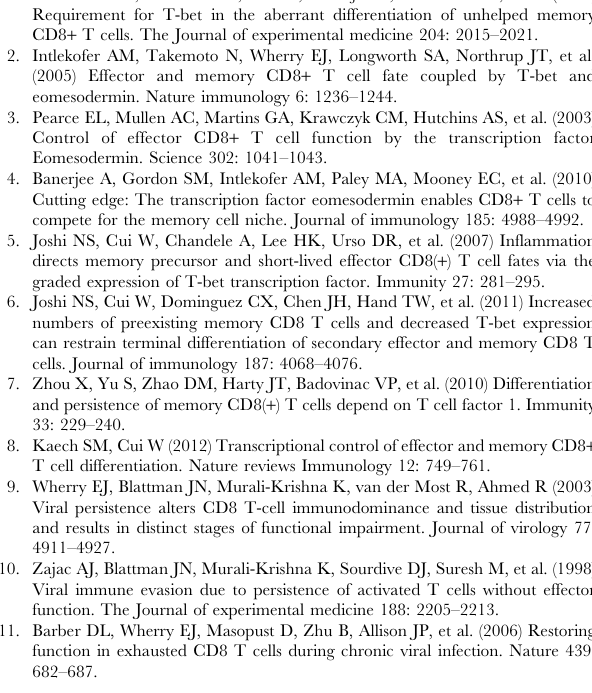
Figure S5 Phenotypic associations of CD8 + T cells in untreated HIV infection. (A) Correlation analysis between co-expression of PD-1, CD160 and 2B4 and the transitional memory (TM) or effector memory (Eff) CD8 + T cell compartment in all untreated HIV infected subjects (n= 52). Spearman non- parametric test was used to test for correlations. (B) Correlation between the frequency of T-bet dim Eomes hi expressing cells and compartmentalization to the TM (CD45RO + CD27 + CCR7 2 ) phenotype (Spearman non-parametric test). (C) Association between the frequency of T-bet hi Eomes dim expressing cells and Eff or effector memory (EM) compartmentalization (Spearman non-parametric test). Memory phenotype distribution of (D) HIV- specific (E) and CMV-specific CD8 + T cells, based on CD45RO, CD27 ad CCR7 expression. Median and IQR are shown for all populations. Figure S6 Cross-sectional correlations between inflam- matory cytokines and T-bet/Eomes expression in un- treated HIV infection. Spearman correlation analyses between plasma levels (pg/mL) of IFN a (n =38), IL-12p70 (n =38), IL-6 (n =38) and TNF (n= 38) and the frequencies of T-bet dim Eomes hi or T-bet hi Eomes dim expressing CD8 + T cells.